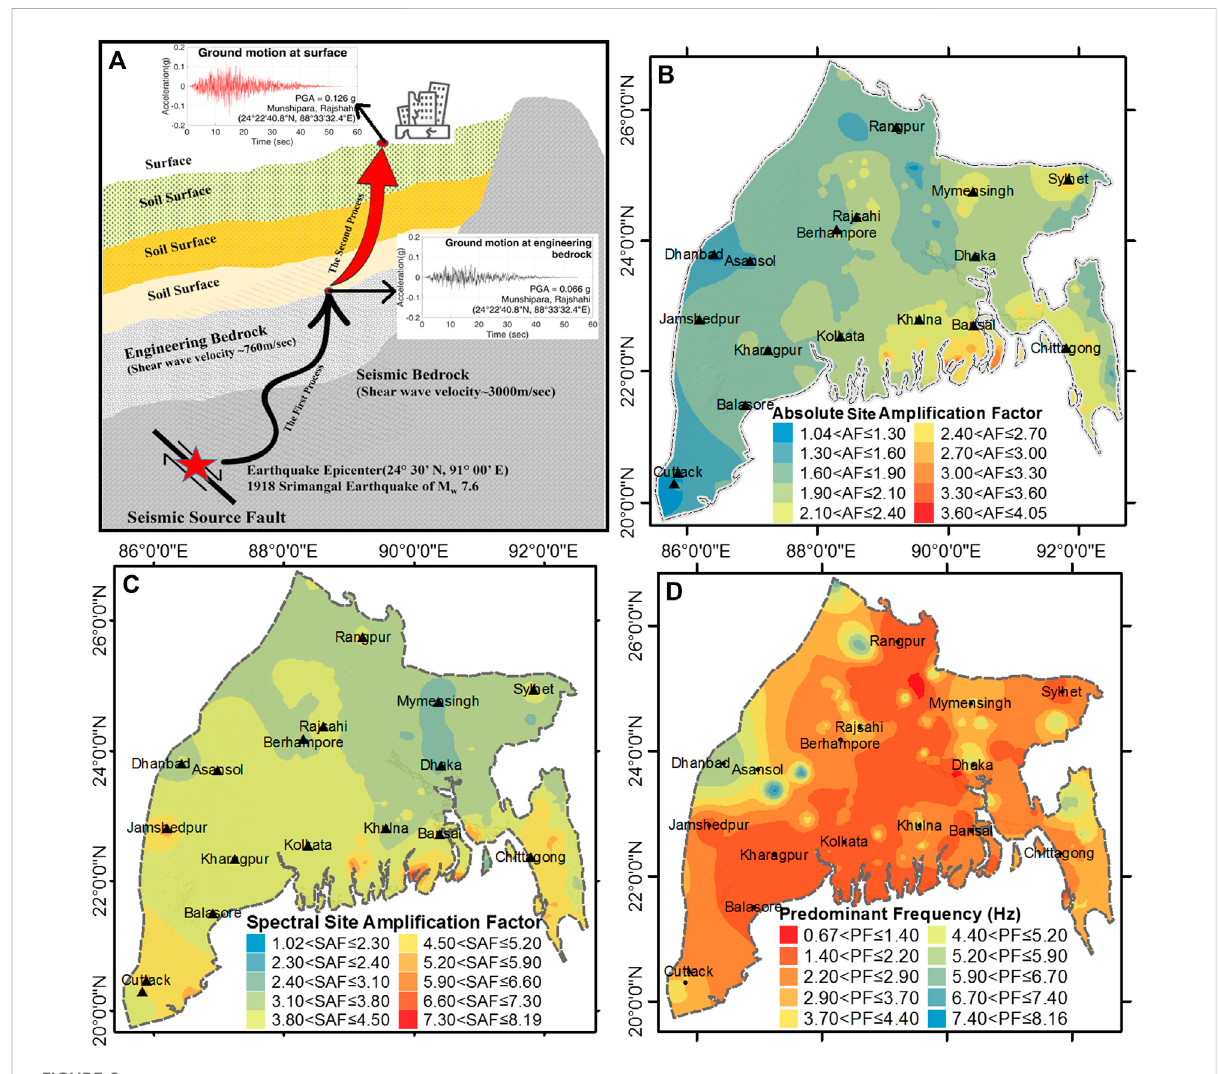
FIGURE 8 (A) Schematic illustration of wave propagation through seismic bedrock to engineering bedrock and through the soil/sediment pro fi le to the surface with a variation in PGA. Spatial distributions on the GIS platform are depicted for (B) absolute site ampli fi cation factor, (C) spectral site ampli fi cation factor, and (D) predominant frequency in Bengal